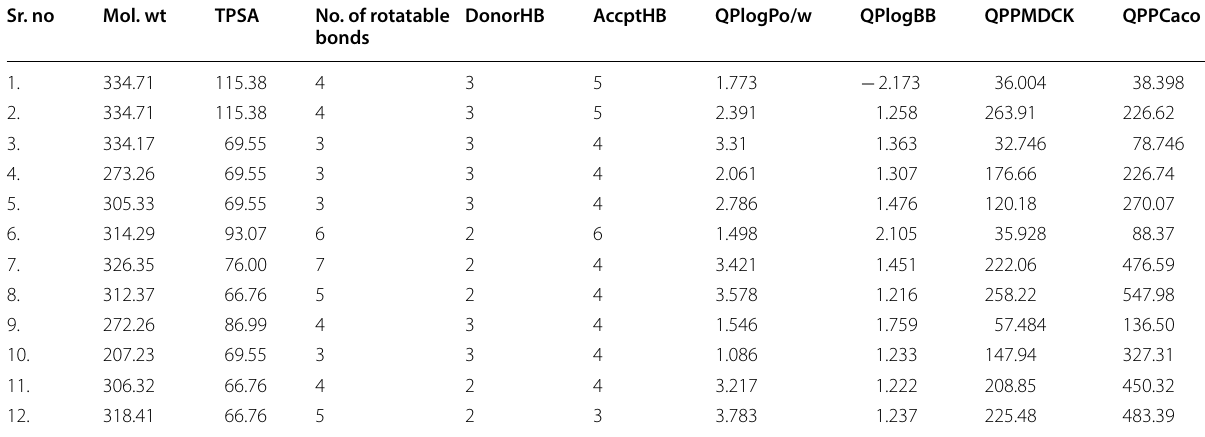
Table 6 All descriptors are generated by the Quickprop software of Schrödinger Sr.